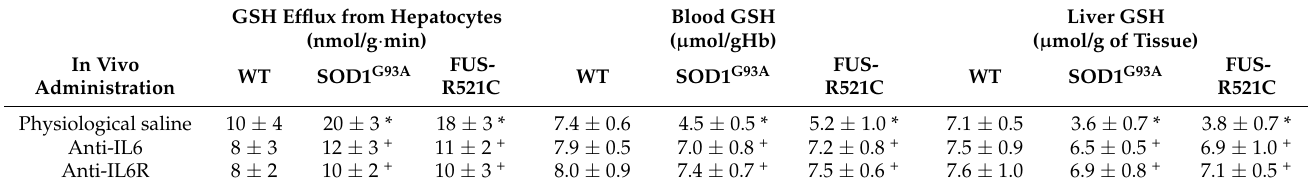
Figure 2. Levels of pro-inflammatory cytokines in cerebrospinal fluid (CSF) and plasma of wild- type and ALS mice. Cytokines were measured as described in Methods. To ensure that the results were comparatively homogeneous, all the mice were subjected to the tests and training indicated in Figure 1. Data in ALS mouse models correspond to an advanced state of progression. Data are mean values ± SD for n = 7. * p < 0.01 comparing values obtained in ALS models versus wild-type controls. Table 3. Administration of anti-IL6 or anti-IL6R mAbs decreases GSH efflux from hepatocytes. Antibodies were adminis- tered, as described in Methods, during the three days prior to isolation of hepatocytes or collection of blood or liver samples. See also the captions of Table 1; Table 2. Rates of GSH efflux were determined in hepatocytes incubated in the presence of amino-acid precursors (as in Table 1). Data in ALS mouse models correspond to an advanced state of progression. Data are mean values ± SD for n = 9 – 10. * p < 0.01 comparing values obtained in ALS models versus wild-type controls. + p < 0.01 values obtained in mice treated with anti-IL6 or anti-IL6R mAbs versus controls treated with physiological saline.